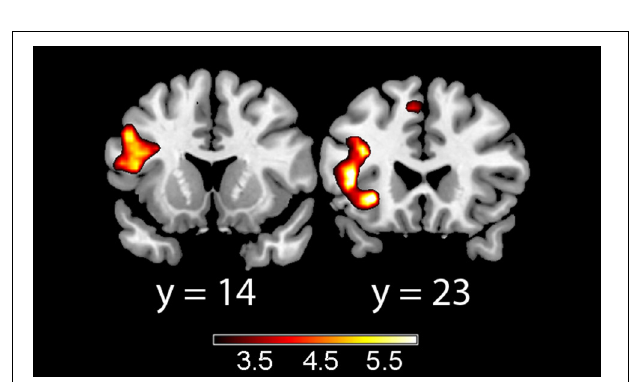
FIGURE 2 | Late acquisition phase unpaired trials for the incongruent > congruent contrast. Showing left inferior frontal gyrus pars trianglaris (left) and left insula (right). Color map represents t